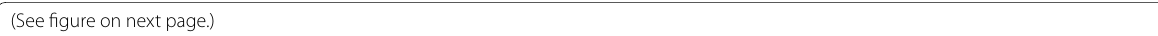
Fig. 1 Distribution of the locations of persons (upper panels) and response category thresholds (lower panels) on the common logit metric from less (lower/negative logit locations) to more (higher/positive logit locations) insomnia (x‑axis) for the Minimal Insomnia Symptom Scale (MISS; A ), the four‑item MISS ( B ), and the MISS‑Revised ( C ). Superimposed green curves represent the information function (IF; higher values more information, i.e., better measurement precision). Maximum IFs (vertical green lines) correspond to logit locations 0.53 (corresponding raw score, 7; Panel A ), 0.77 logit (corresponding raw score, 10; Panel B ), and 0.57 (corresponding raw score, 7; Panel